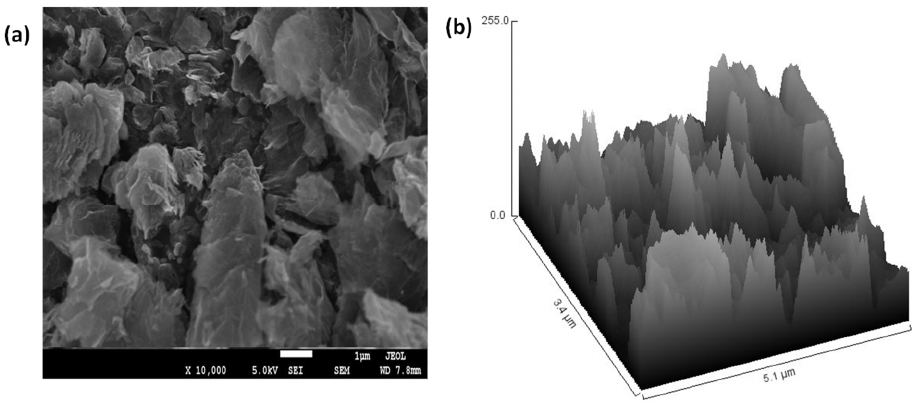
Figure 3. ( a ) SEM image of GO, ( b ) Hill stack plot from the SEM image of GO.